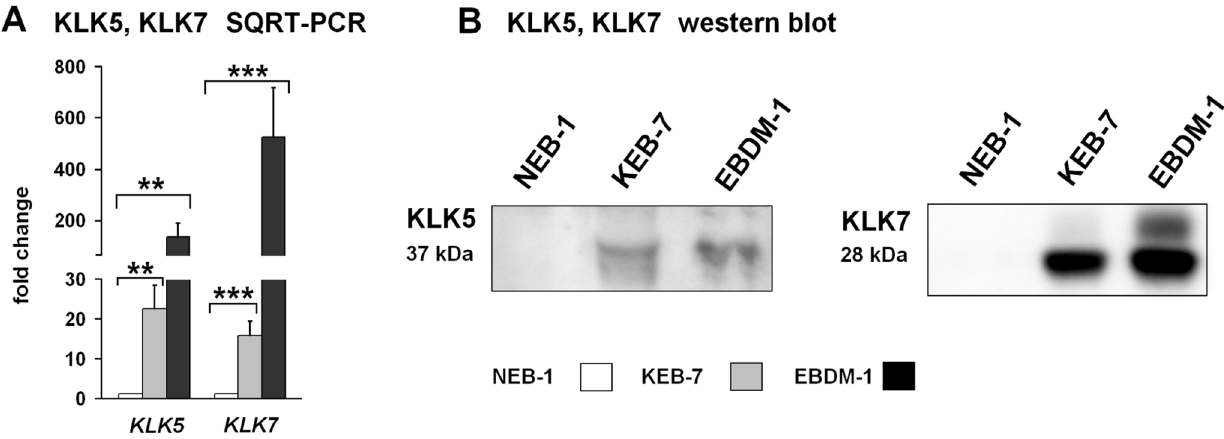
Figure 1. Expression of KLK5 and KLK7. A. SQRT-PCR shows increased KLK5 and KLK7 mRNA expression in EBS-DM cell lines (n=4 to n=5). B. Increased expression of KLK5 and KLK7 protein in EBS-DM cell lines determined in 48-h-conditioned cell culture supernatant by western blot.